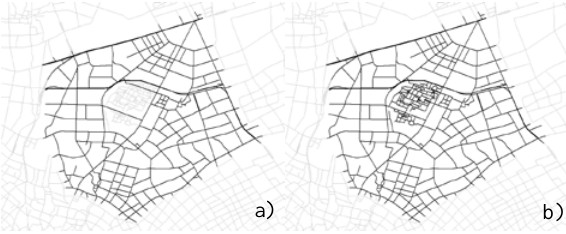
Figure 7. Neighbouring road network for the study area: a) without interior roads of Danwei and Xiaoqu and, b) with interior roads of Danwei and Xiaoqu. Figure 8 is an overview of original betweenness values in study area. These values are normalized and colour coded from blue to red to indicate the increasing betwenness values. Before integrating the interior roads of Danwei and Xiaoqu, Siping Road has the highest betweenness value, followed by Miyun Road and Inner Ring Elevated Road/Zhongshan North 2nd Road. Zhangwu Road, Chifeng Road and Guokang Road have rather low betweenness values. After the integration, betweenness values of Chifeng Road and Guokang Road are significantly increased, and the betweenness value of Zhangwu Road is also slightly increased.